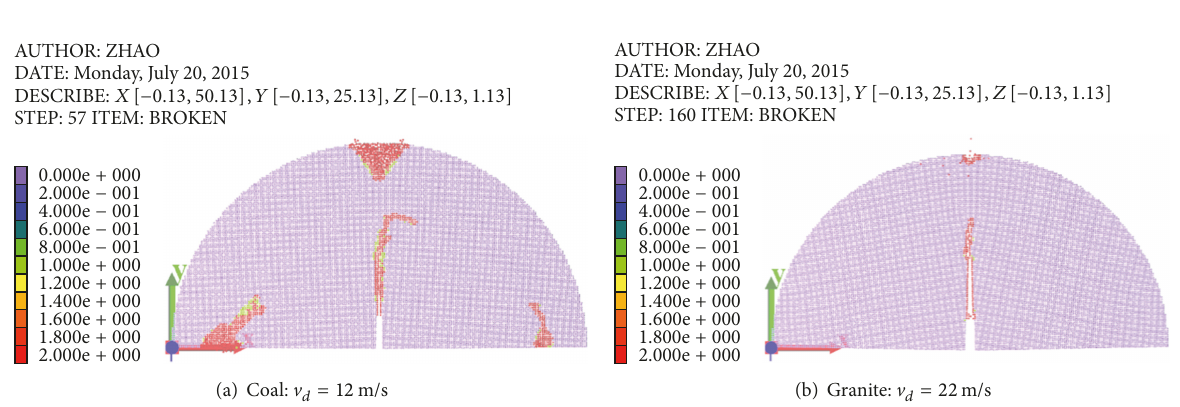
Figure 15: Damage morphology of partial rock